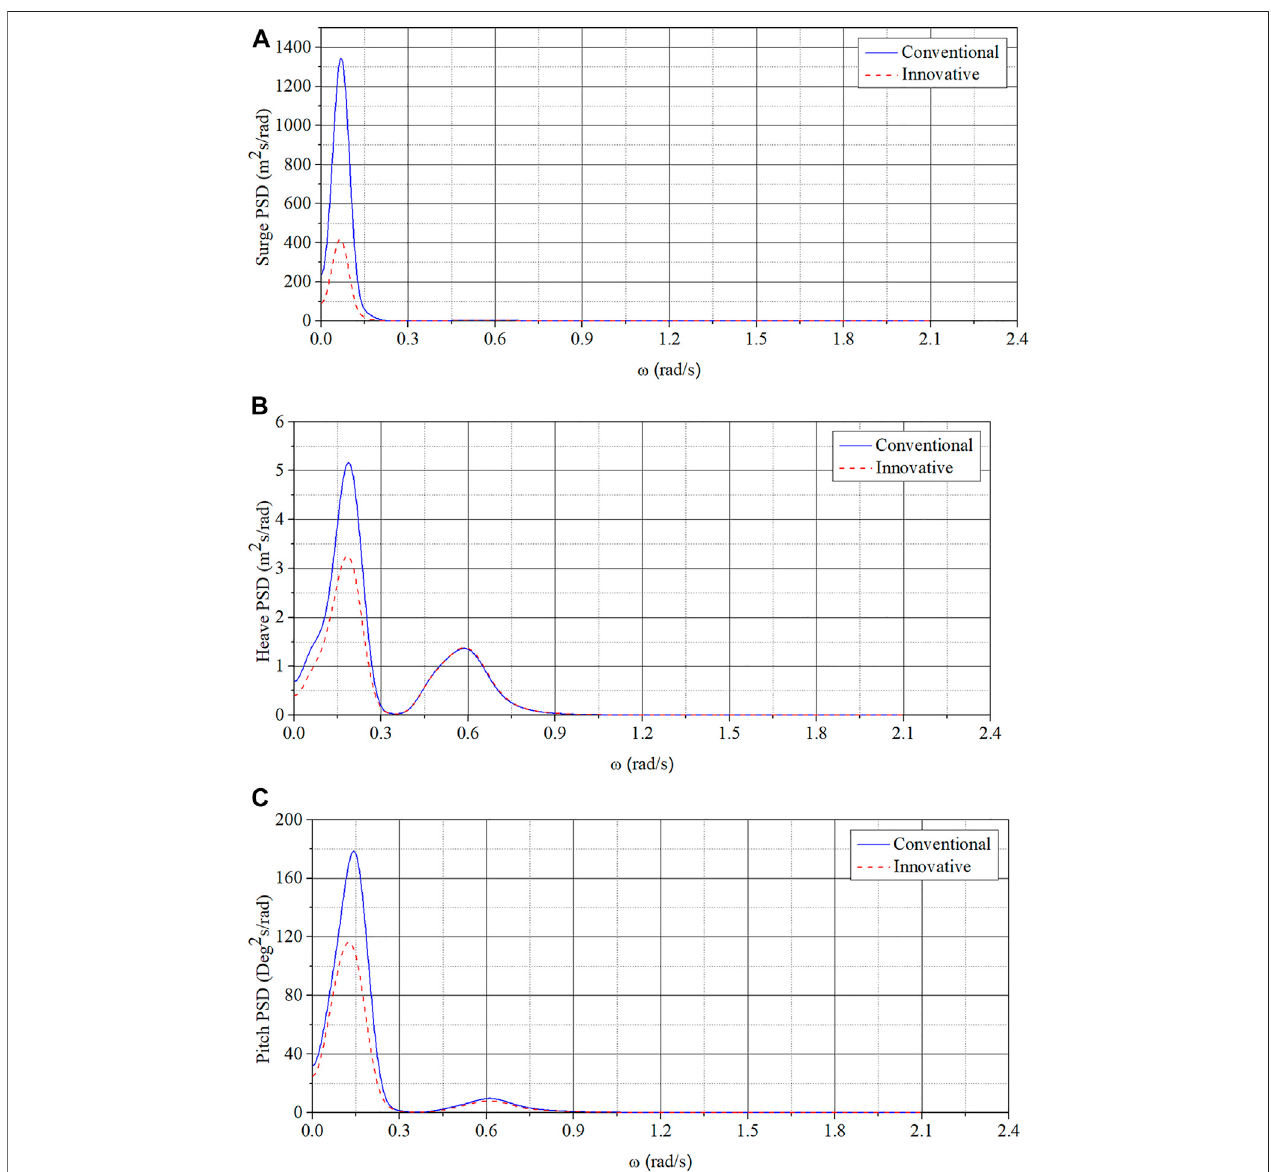
FIGURE 9 | PSD of motion responses. (A) Surge. (B) Heave. (C)